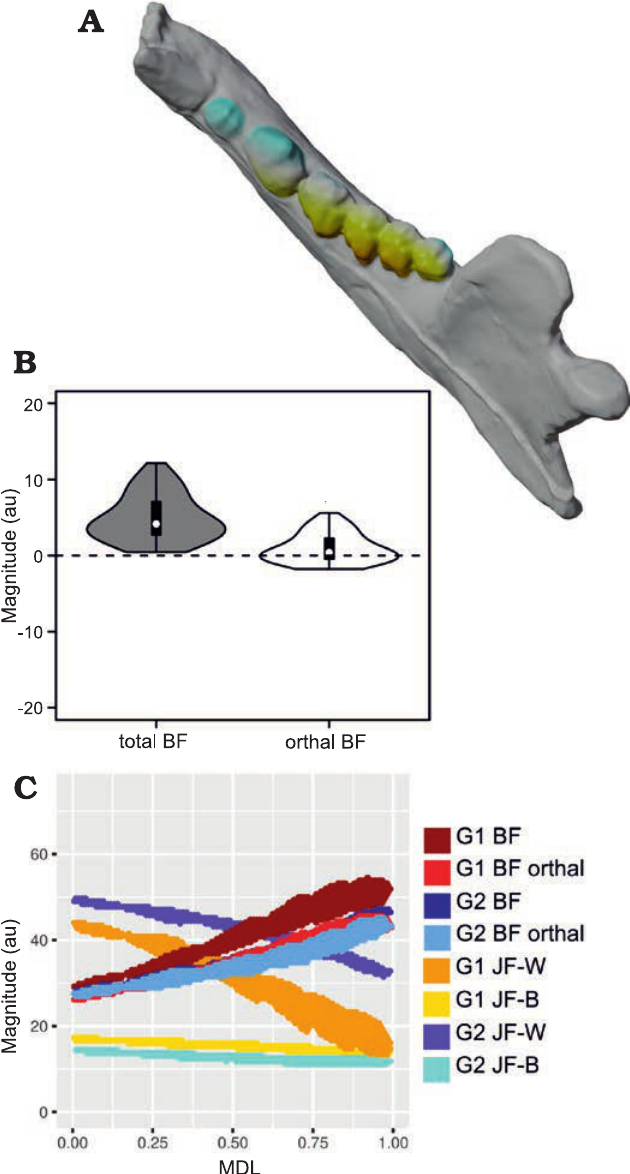
Fig. 5. Results of Group 1 (G1) minus Group 2 (G2) analysis of orthal bite force (BF) for Peligrotherium tropicalis Bonaparte, Van Valen, and Kramarz, 1993. A . Lower left working-side hemimandible of P. tropicalis with postcanine crowns colorized by relative G1 vs. G2 advantage (yellow shows areas where G1 produces higher orthal BF, while bluer colors corre- spond to higher G2 BF values; white areas are where G1 and G2 forces are sub-equal). B . Violin boxplot showing distribution of total GP1 minus GP2 BF and its orthal component marginal over all locations in the postcanine tooth-row (TR). C . 2D histogram plot showing distribution of estimated bifulcral force magnitudes for G1 and G2 muscle recruitment regimes, as a function of mesiodistal location (MDL). JF-W/B, working-/balancing-side joint